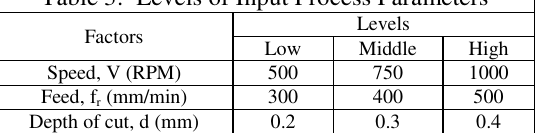
Table 3: Levels of Input Process